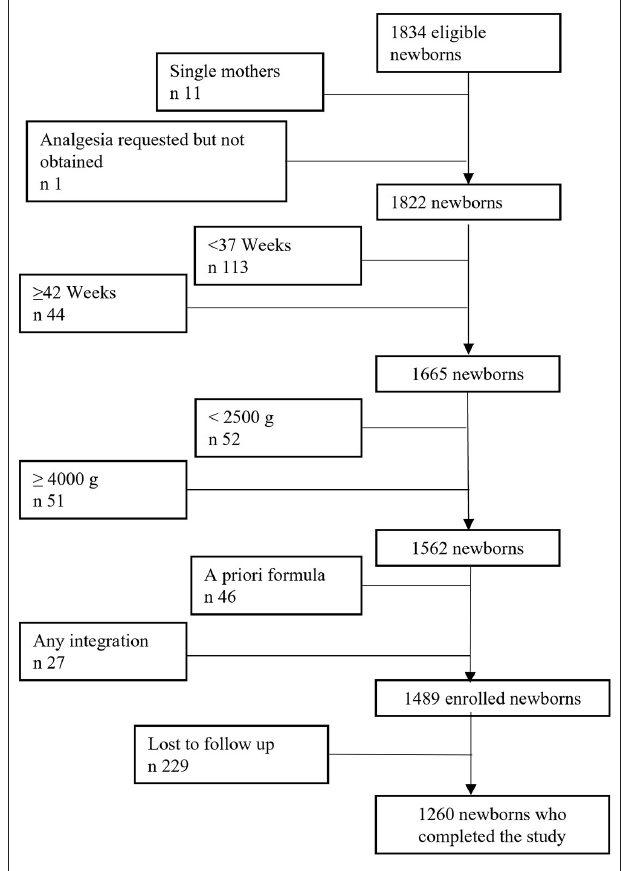
FIGURE 1 | Dyads’ flow through the